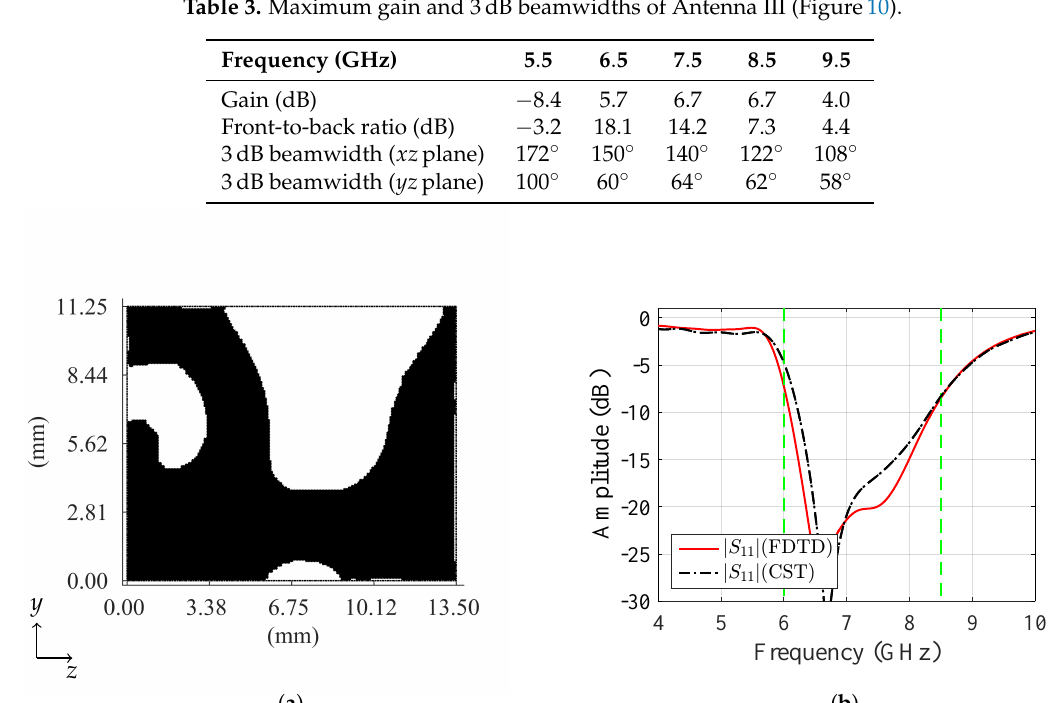
Figure 10. Antenna III: ( a ) The shape of the antenna optimized to radiate over the frequency band 6.0–8.5 GHz and to filter the frequencies 3.5–6.0GHz and 8.5–11.0GHz. ( b ) The antenna reflection coefficient. The operational band is marked by the green dashed